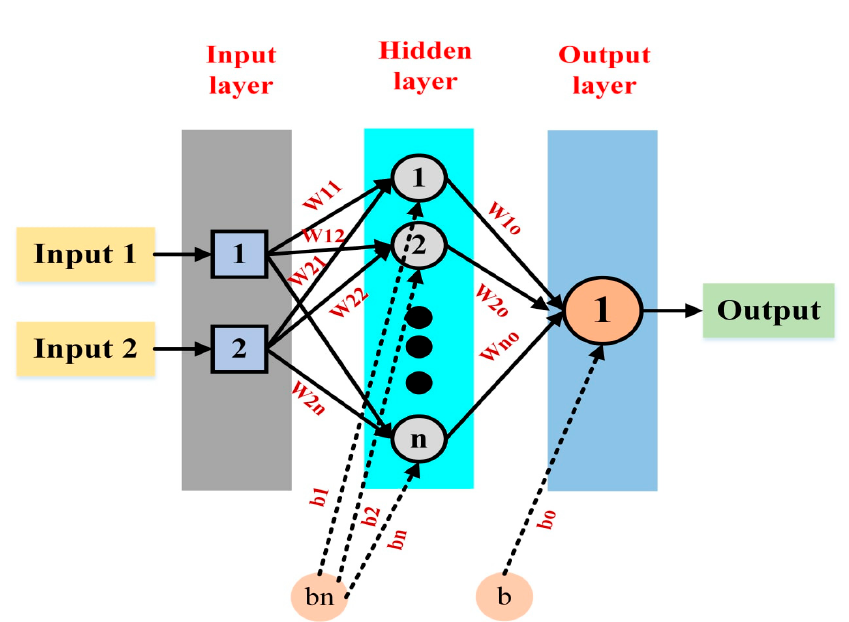
Figure 5. Structure of an NN model.